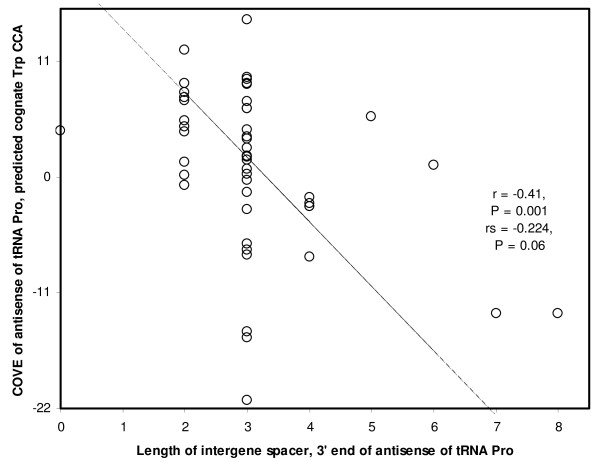
Cloverleaf stability of antisense of tRNA Pro as a function of the accuracy of processing of its 3' extremity by sense RNA maturation. The x axis is the number of nucleotides between the next sense gene (tRNA Thr) and the 3' extremity of the antisense of tRNA Pro. Datapoints are for the same species as in Figure 3, but species excluded for lack of anticodon symmetry between sense and antisense tRNAs differ.